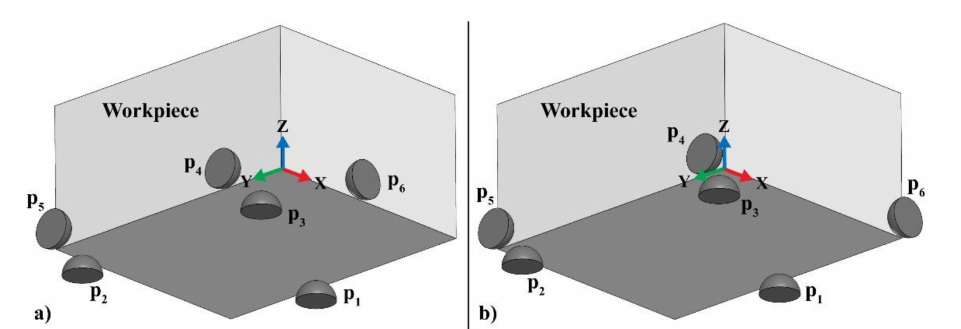
Figure 2. First ( a ) and second ( b ) configuration of the